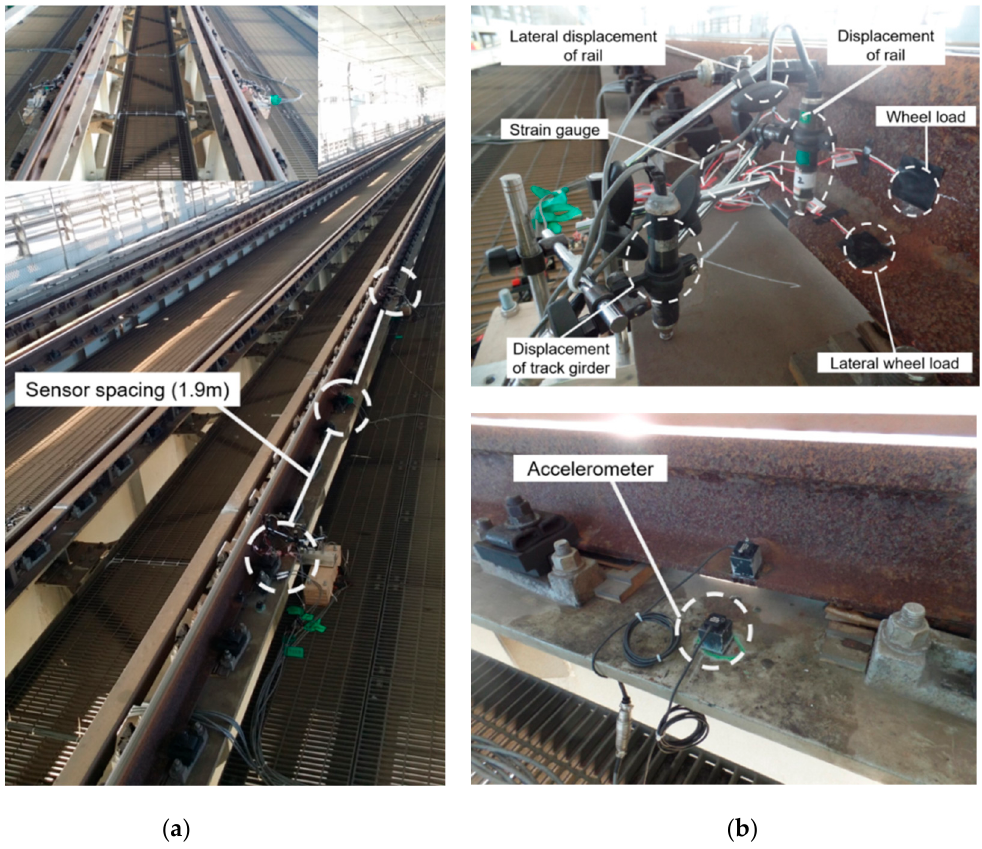
Figure 3. Sensor installation. ( a ) Location of the measurement and ( b ) vertical and lateral wheel load strain gages, strain gages, vertical rail, and track girder displacements measured using displacement transducers mounted on a jig anchored at the side bridge inspection passage, which is not affected by the passing train [2].